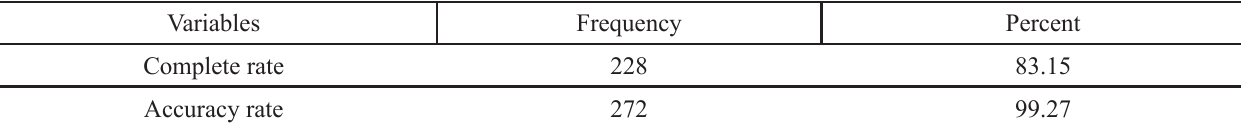
Table 3. Completion and accuracy rate of the EMS 115 Care Report form for traffic injured in Mashhad Social Welfare Hospitals, 2018